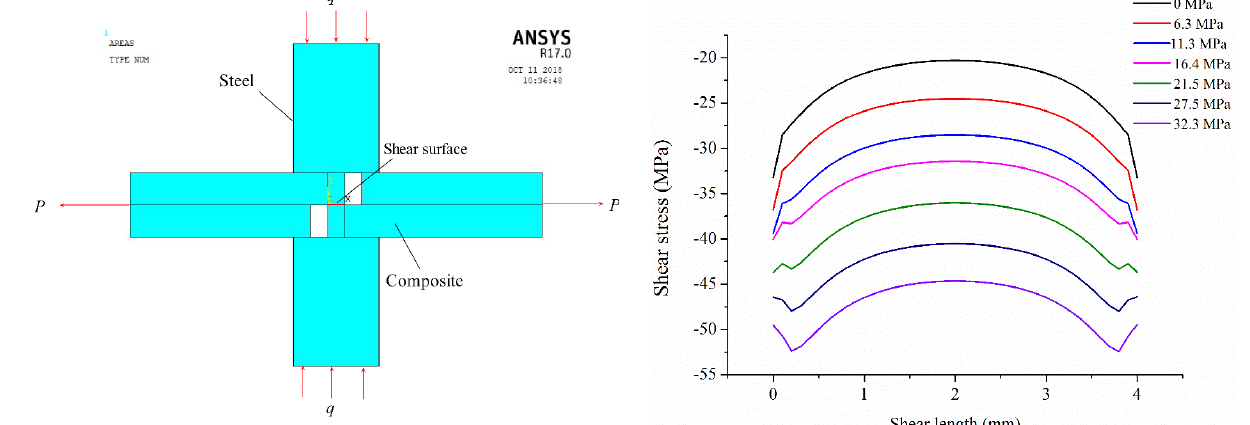
Figure 14: Shear stress distribution of specimen under different external normal stresses Table 4: Shear stresses and normal stresses at the characteristic points External normal stress